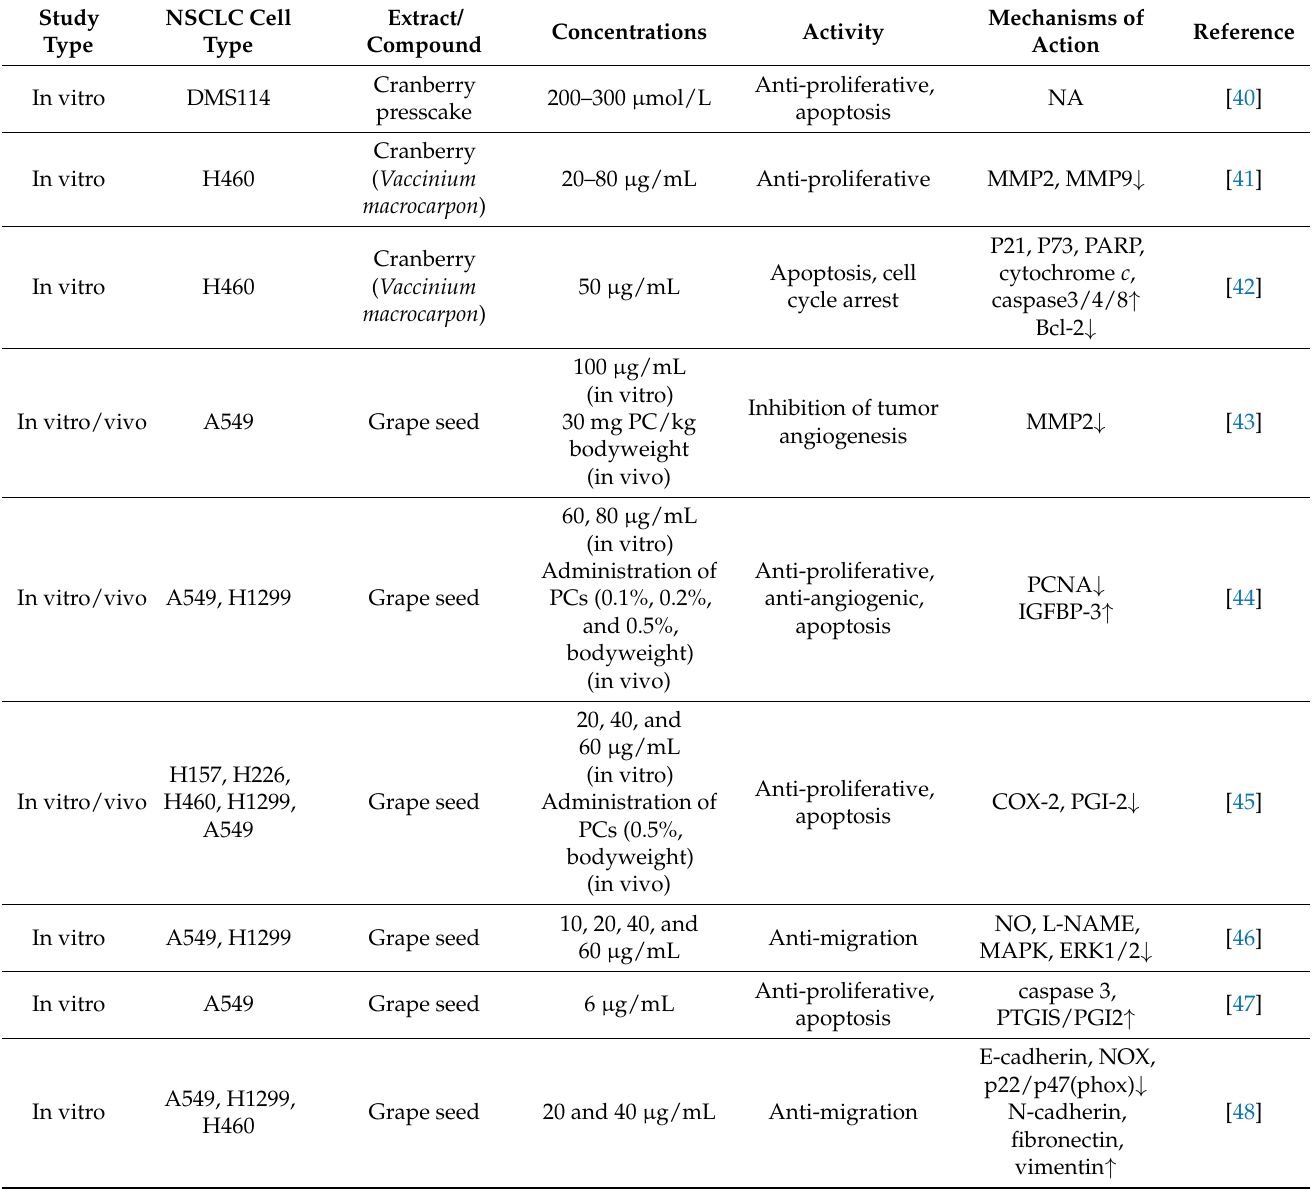
Table 1 highlights the molecular mechanisms of PCs in nicotine-induced NSCLC treatment. Table 1. The molecular mechanisms of PCs in nicotine-induced NSCLC